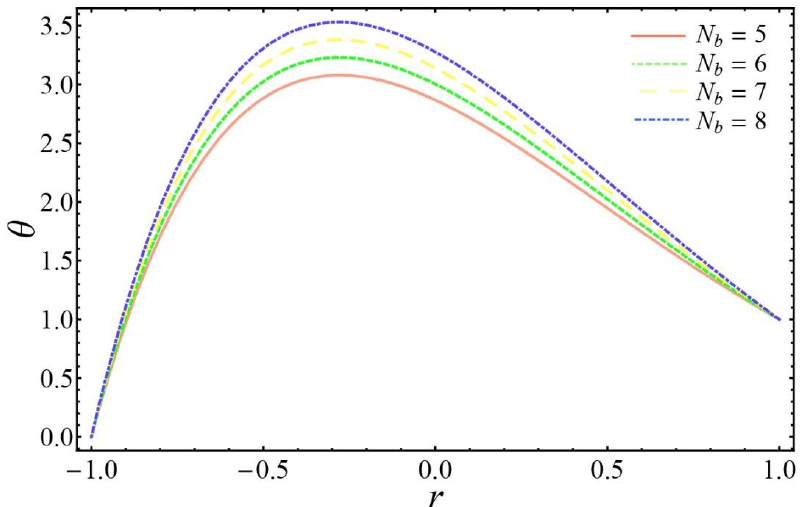
Figure 4. Variation of complaint wall parameters on u when 𝜖 = 0.6; 𝛽 = 0.01; 𝑘 = 2; 𝑥 = 0.2; 𝑡 = 0; 𝑁 𝑐 = 2; 𝑁 𝑟1 = 1; 𝑄 = 10.